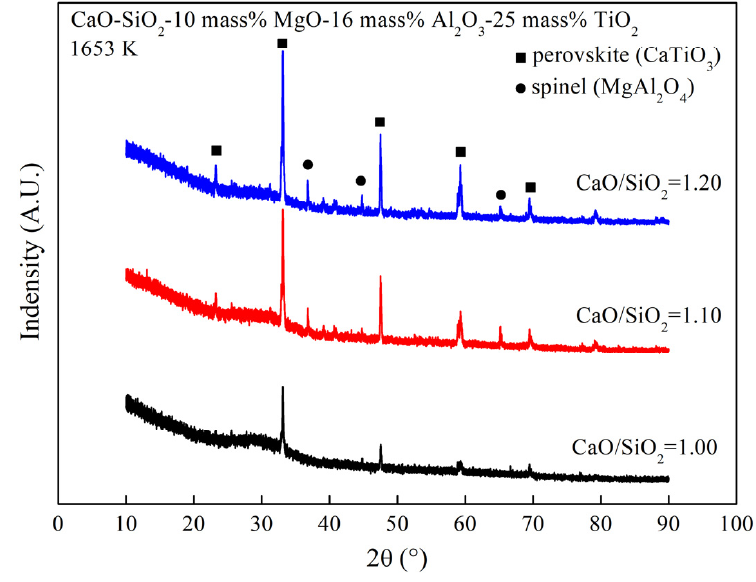
Figure 6. XRD curves of the slag containing different basicity at 1653 K.